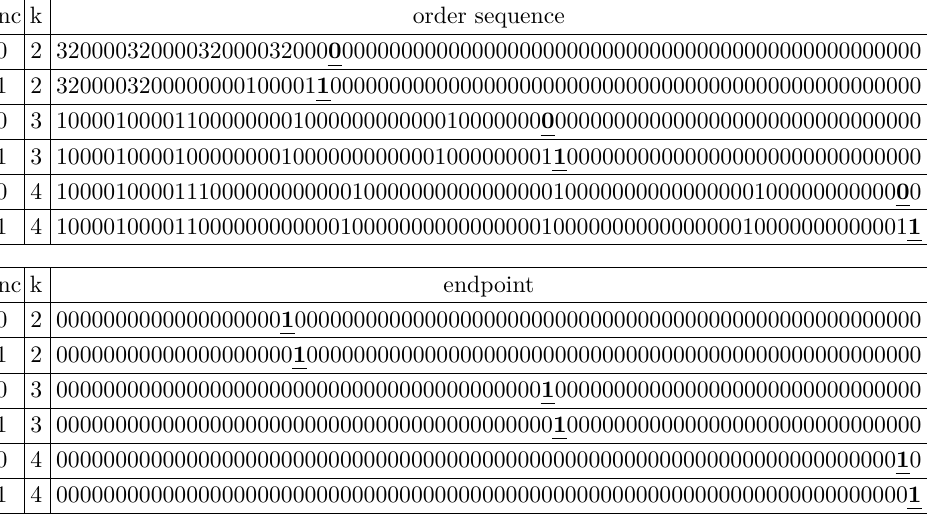
Table 2: Predefined order sequence and endpoint during sampling Enc